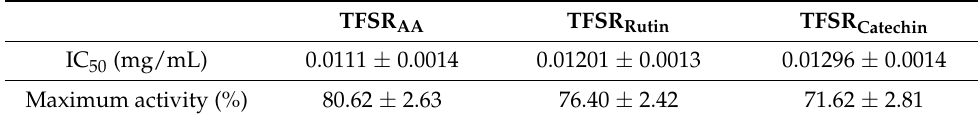
Table 2. Relative Antioxidant Capacity